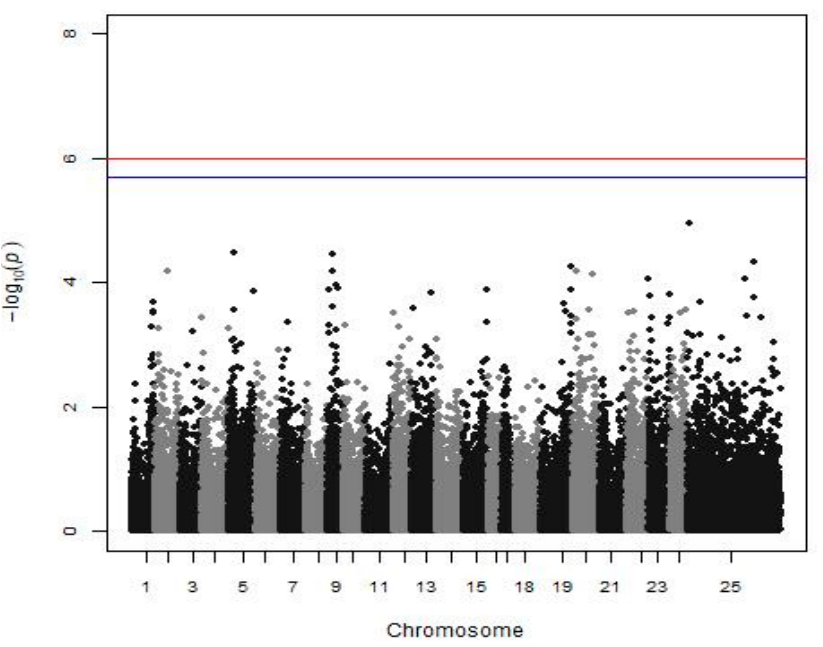
Figure 3. Manhattan plot shows the results of disease resistance against Vibrio (a subgroup of batch 10). The red (initial value 0.05) and the blue line (initial value 0.1) illustrate the threshold after the Bonferroni correction (at the genomic level).